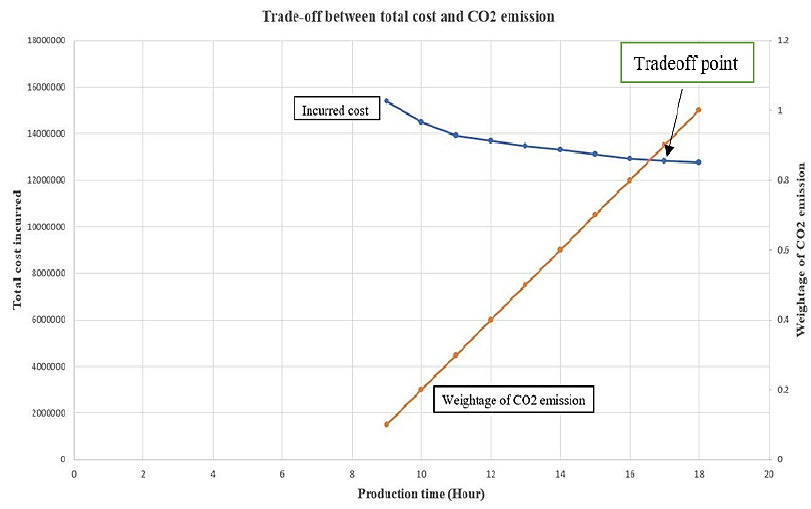
Fig. 6. Tradeoff between total cost and production